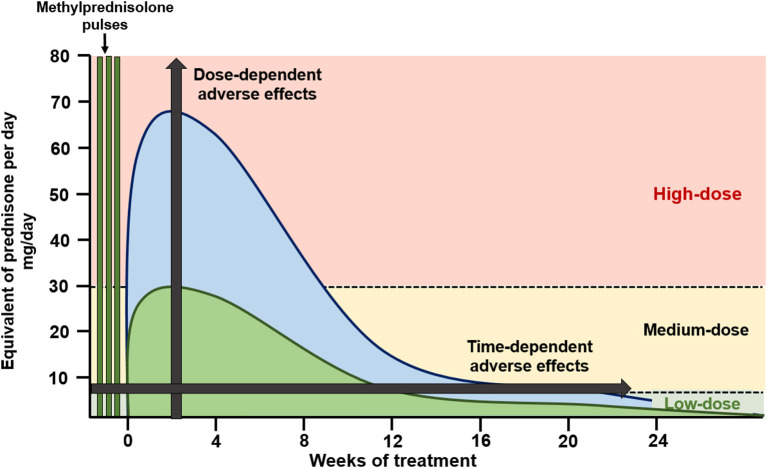
Glucocorticoid dosing in induction of remission schemes. High-dose oral glucocorticoid schemes (blue) apply starting doses of oral glucocorticoids at 0.8–1.0 mg/kg/day, with slow tapering, reaching low glucocorticoid doses by 24 weeks of therapy. Recent schemes (green) apply methylprednisolone pulses followed by medium starting doses of oral glucocorticoids (<0.5 mg/kg/day) with a faster tapering, reaching low glucocorticoid doses by 12 weeks of therapy.